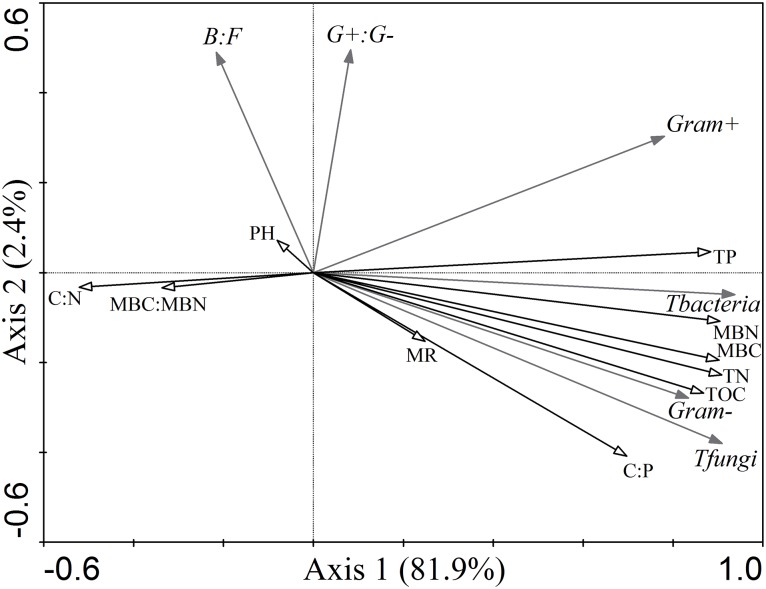
Redundancy analyses between soil microbial PLFAs and chemical parameters.Tbacteria: total bacteria PLFAs; Tfungi: total fungi PLFAs; Gram+: gram-positive bacteria; Gram-: gram-negative bacteria; B:F: the ratio of bacteria to fungi; G+:G-: the ratio of gram-positive bacteria to gram-negative bacteria. TOC: total organic carbon; TN: total nitrogen; TP: total phosphorus; MBC: microbial biomass carbon; MBN: microbial biomass nitrogen; C:N: the ratio of TOC to TN; C:P: the ratio of t to TP.